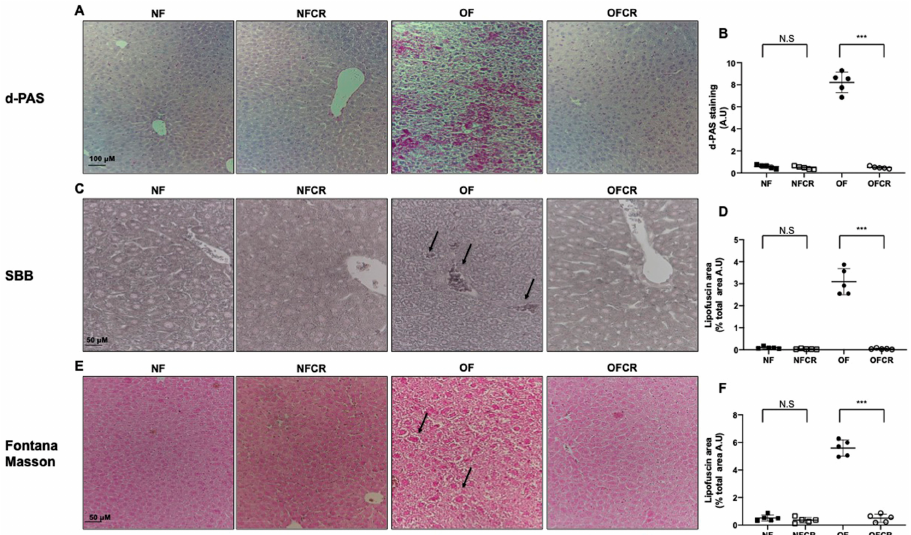
Figure 4. Lipofuscin accumulation using diastase periodic-Schiff (d-PAS), Sudan black B (SBB) and Fontana Masson staining in the livers of the animals in the NF, NFCR, OF and OFCR groups at 7 months of age. d-PAS staining ( A ) was evaluated in the NF, NFCR, OF and OFCR groups at 20×. d-PAS staining was quantified using ImageJ ( B ), *** p < 0.001; N.S: nonsignificant, p > 0.05. SBB staining ( C ) (arrow in the OF group) was evaluated in the NF, NFCR, OF and OFCR groups at 40×. SBB staining was quantified using ImageJ ( D ), *** p < 0.001; N.S: nonsignificant, p > 0.05. Fontana Masson staining ( E ) (arrow in OF group) was evaluated in the NF, NFCR, OF and OFCR groups at 40×. Fontana Masson staining was quantified using ImageJ ( F ), *** p < 0.001; N. S: nonsignificant, p > 0.05. These pictures are representative images from n = 5 animals/group.